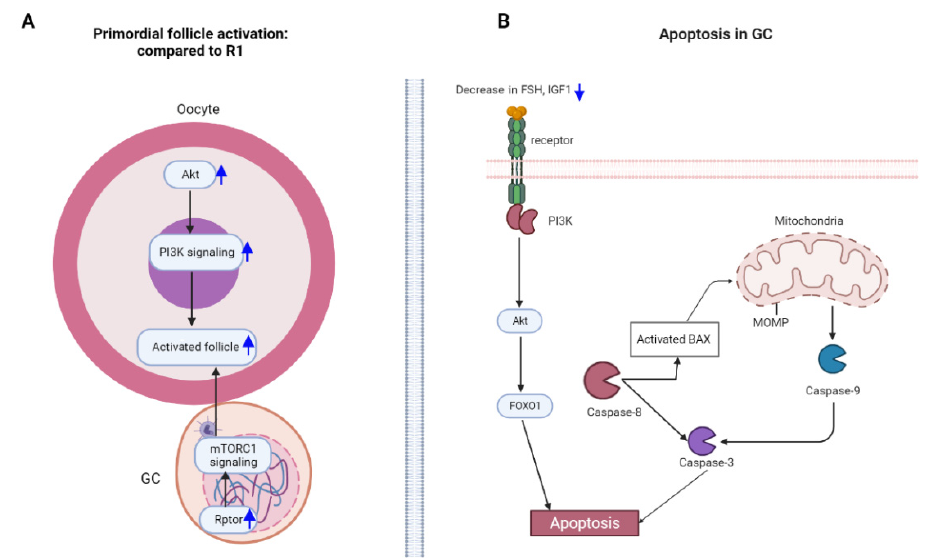
Figure 5. Schedule of repeated superovulation regulating primordial follicle activation and granulosa cell apoptosis. ( A ), schedule of regulating primordial follicle activation by repeated superovulation; ( B ), schedule of granulosa cell apoptosis. GCs—granulosa cells; R1—superovulated 1 time.